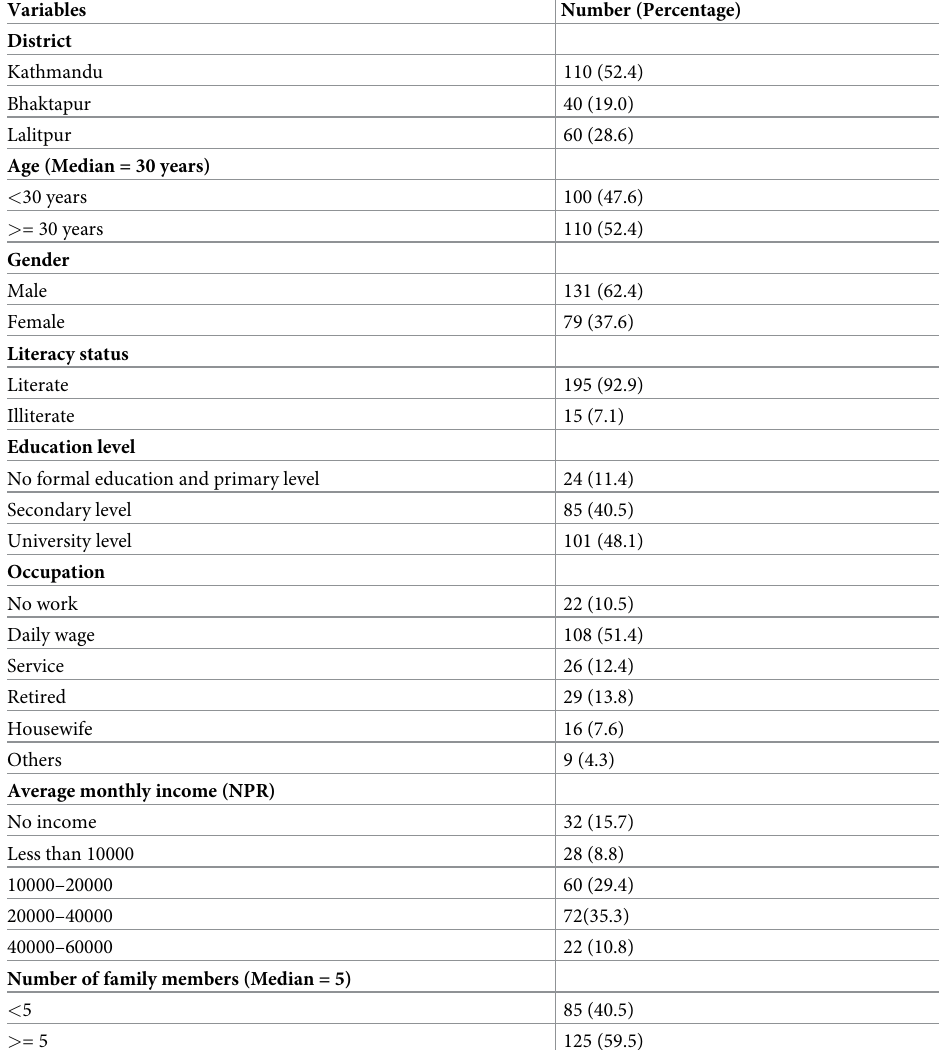
Table 1. Demographic characteristics of the study